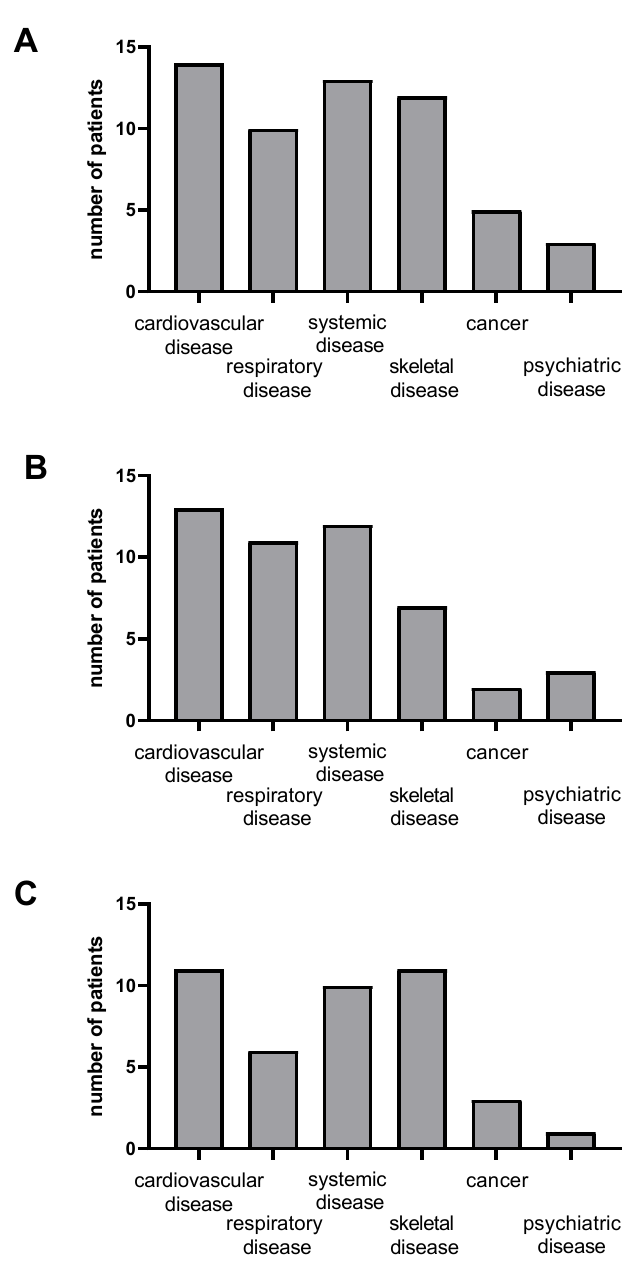
Figure 7. Distribution of pre-existing disease and main COVID-19-related symptoms. ( A ) Fatigue group, ( B ) neurocognitive disorders group, ( C ) pain group. No difference between groups (chi- squared test).